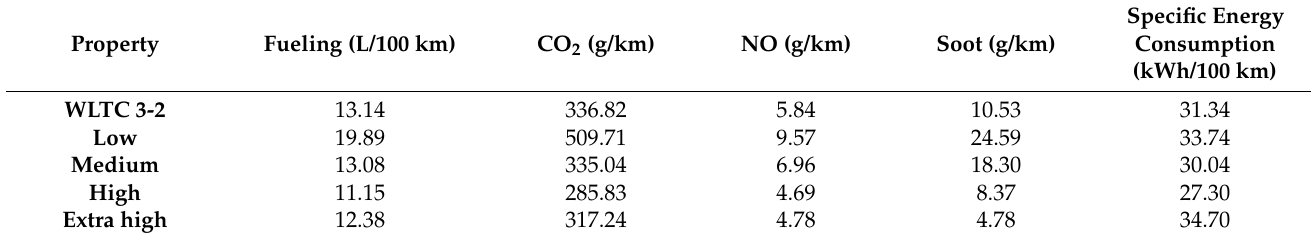
Table 5. Distance-specific results for the type-approval case (zero wind).